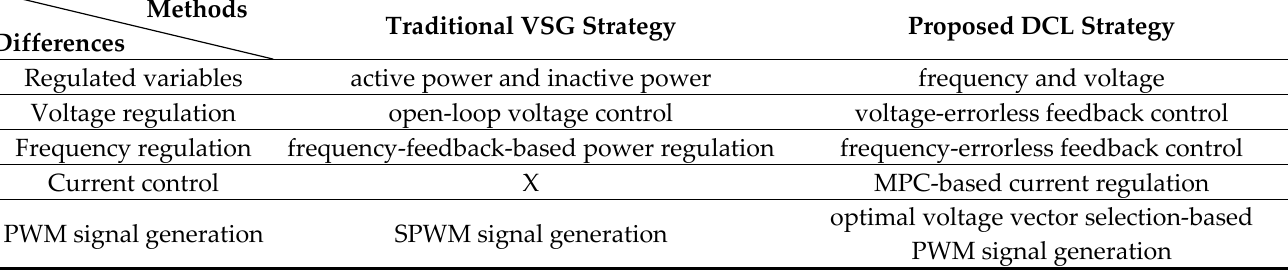
Figure 2. Structure of proposed DCL control strategy for microgrid working at island mode. Table 1. Comparisons of traditional VSG strategy and proposed DCL strategy.